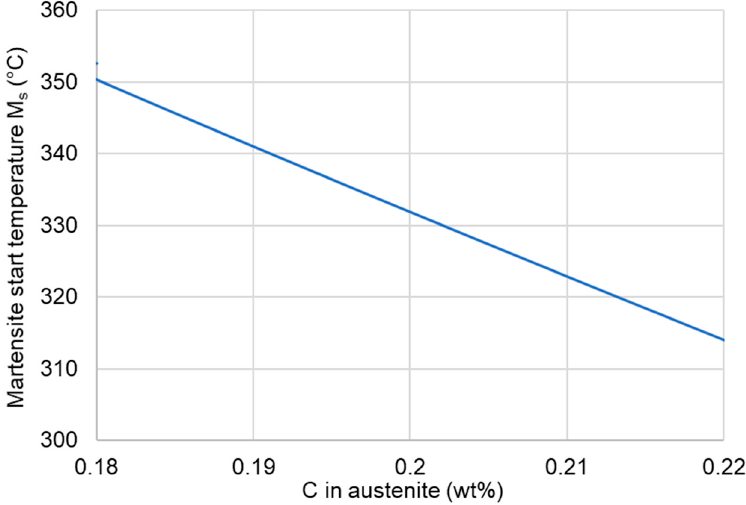
Materials 2020 , 13 , x FOR PEER REVIEW Figure 3. Martensite start temperature calculated using JMatPro. Figure 3. Martensite start temperature calculated using JMatPro.